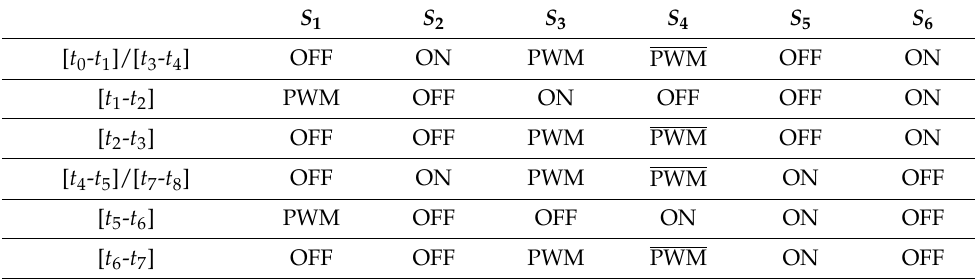
Table 1. Operation of the power electronic switches for